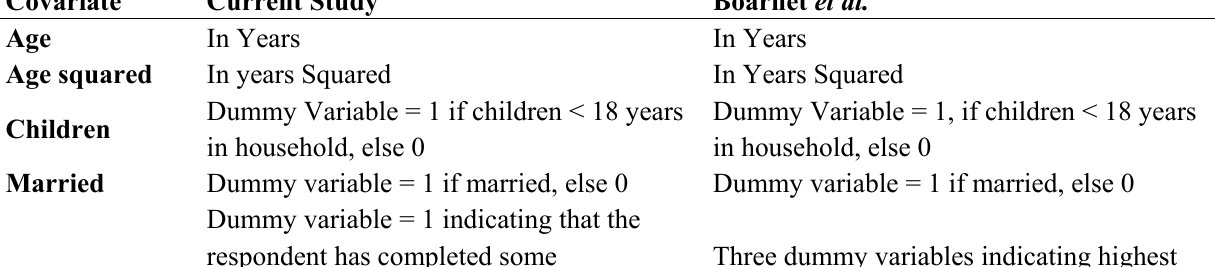
Table 1. Comparison of covariates used in the current study and Boarnet et al. , [22].